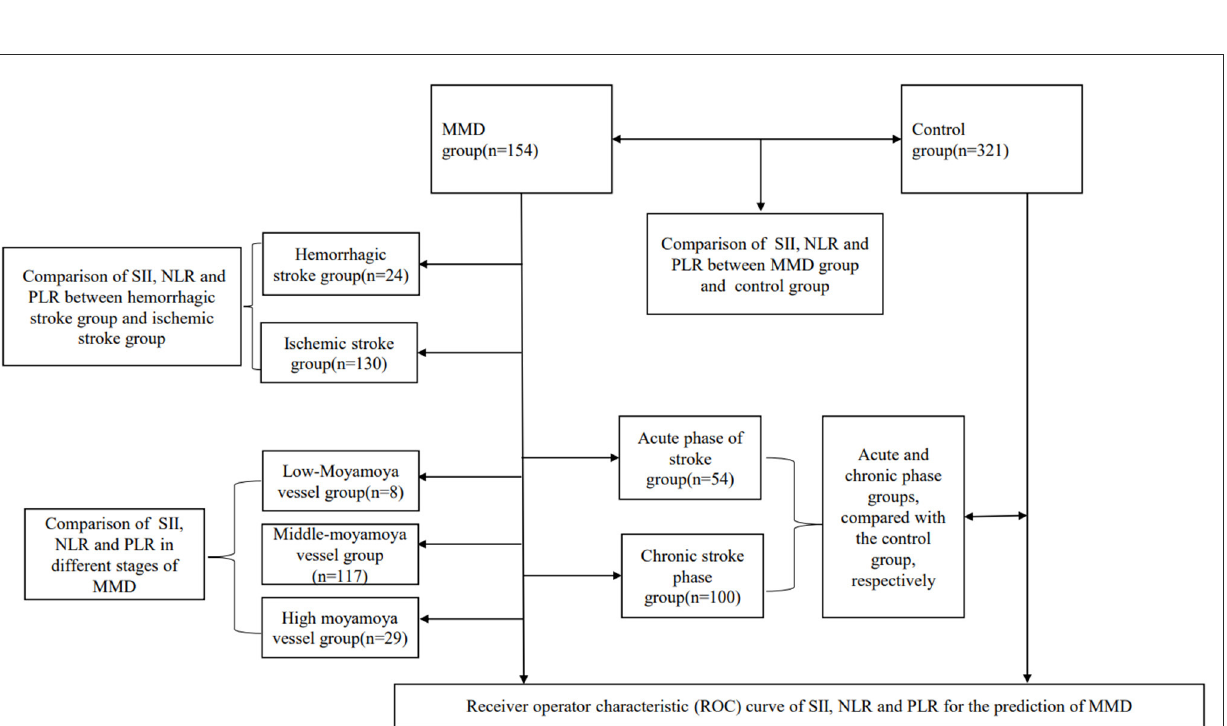
FIGURE2 Experimental flow